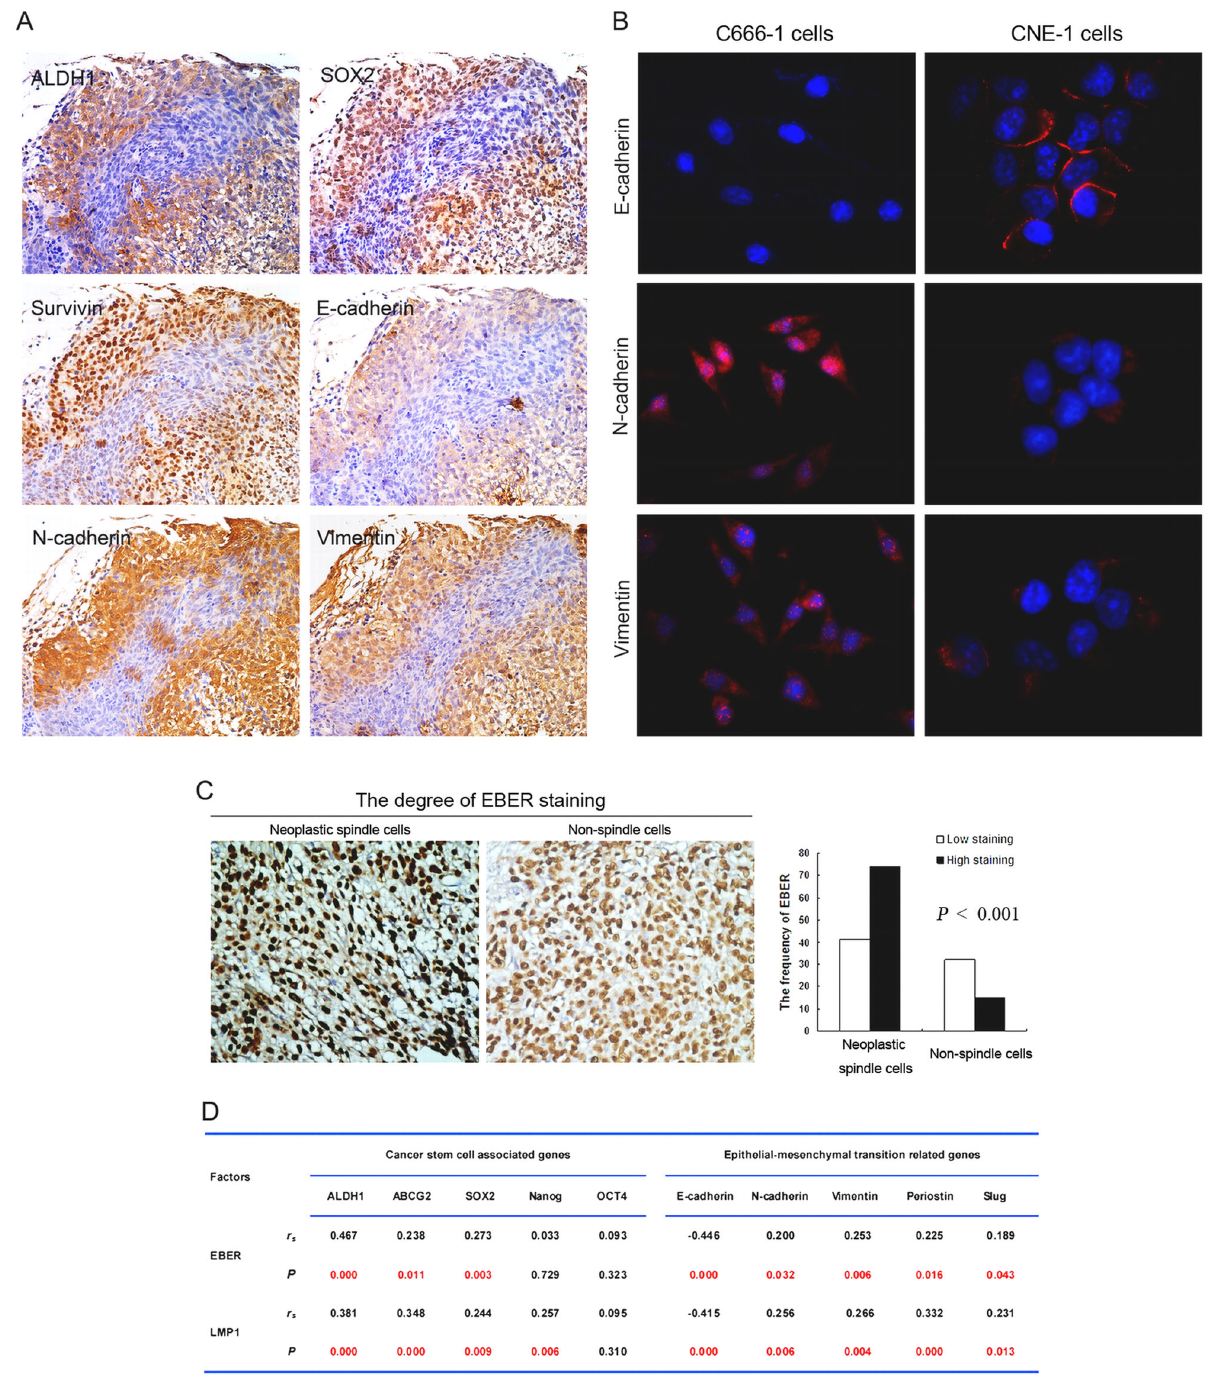
Figure 3. Stem-like spindle cells are strongly associated with EMT -like phenotypic changes and EBV infection. (A) Serial sections from the same patient showed aberrant expression of EMT indicators E-cahderin, N-cadherin and Vimentin in stem-like spindle cells. (B) Spindle-like C666-1 cells had strong fluorescence staining of N-cadherin and Vimentin, and weak staining of E- cadherin compared with epithelial-like CNE-1 cells. (C) Representative images show that high expression (dark brown) of EBV- encoded small RNA (EBER) was observed in neoplastic spindle cells in comparison with non-spindle cells in the same tumor. (D) The significant relationship was found between EBER, EBV-encoded protein LMP1 and CSCs/EMT-related markers. Differences statistically significant at P values <0.05. doi: 10.1371/journal.pone.0083135.g003 PLOS ONE |